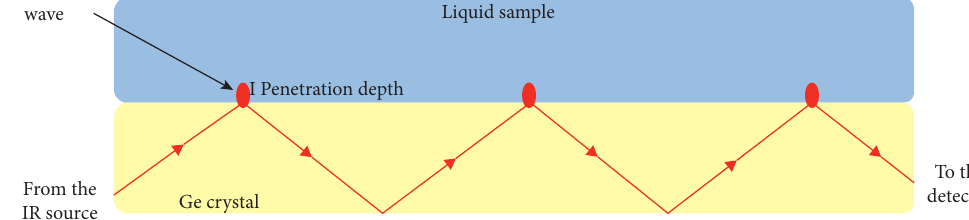
Figure 6: Setup for an ATR crystal